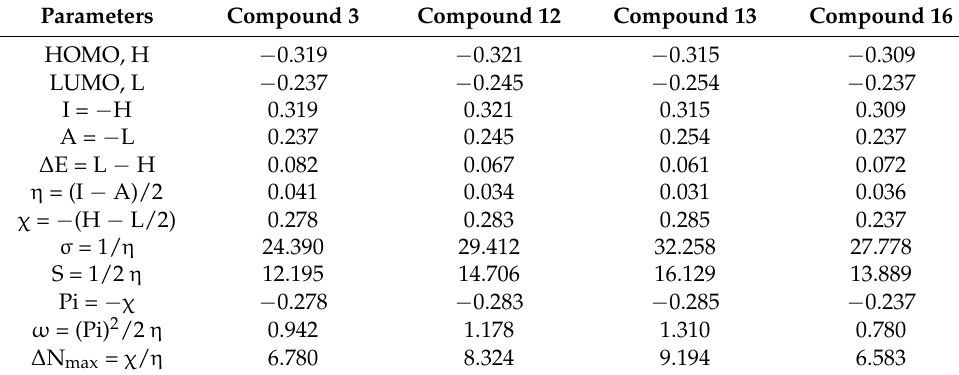
Table 6. Calculated charges on donating sites and energy values (HOMO, LUMO, Energy gap ∆ E/eV, hardness ( η ), global softness (S), electro negativity ( χ ), absolute softness ( σ ), chemical potential (Pi), global electrophilicity ( ω ) and additional electronic charge ( ∆ N max ) of the studied four compounds by using DFT calculations. Parameters Compound